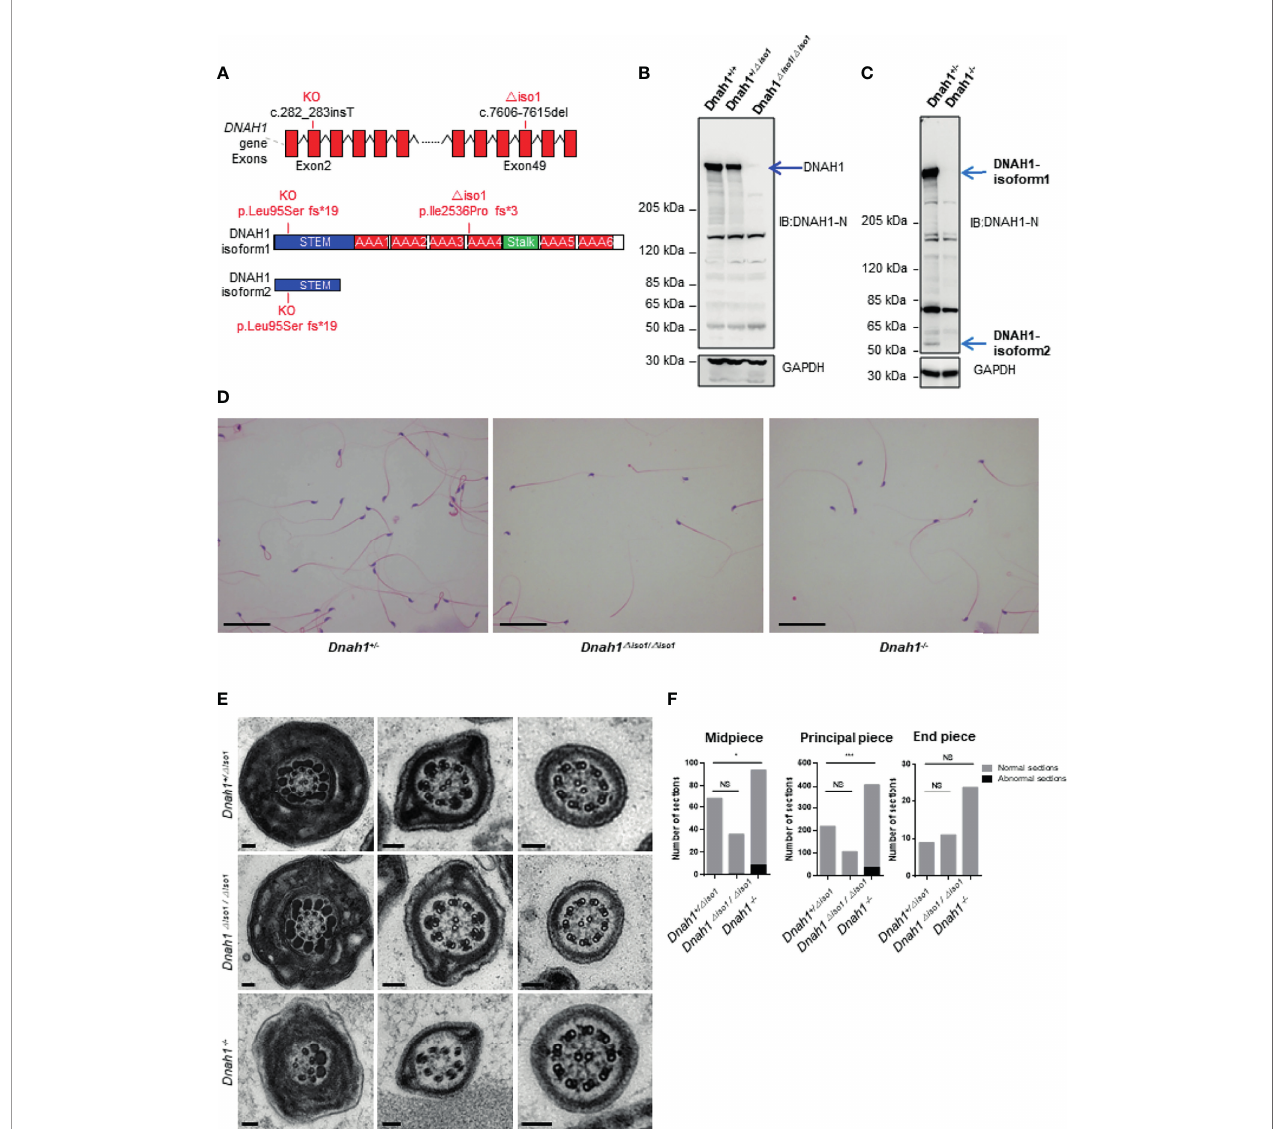
FIGURE 3 | Generation of Dnah1 -/- and Dnah1 △ iso1/ △ iso1 mice. (A) Representative Dnah1 structure and strategy used to generate Dnah1 -/- and Dnah1 △ iso1/ △ iso1 mice through CRISPR/Cas9 genome editing technology by targeting exon 2 and exon 49, respectively. (B, C) Western blotting analysis con fi rmed the deletion of full- length DNAH1 protein in Dnah1 -/- and Dnah1 △ iso1/ △ iso1 mice testes, while isoform2 (50 kDa) still existed in Dnah1 △ iso1/ △ iso1 mice testes. GAPDH was used as an internal control. (D) The sperm morphology analysis of Dnah1 △ iso1/ △ iso1 mice displayed spermatozoa without a sperm tail. Scale bars, 10 um (E) Transmission electron microscopy investigation of Dnah1 △ iso1/ △ iso1 mice spermatozoa showing an intact ultrastructure with the presence of a central pair and outer dense fi bers, while abnormal sections were observed in Dnah1 -/- mice spermatozoa. Scale bars, 10 um. (F) Quanti fi cation of normal and abnormal sections observed in the spermatozoa of Dnah1 -/- and Dnah1 △ iso1/ △ iso1 mice. *p < 0.05, ***p < 0.001 and NS, no signi fi cant